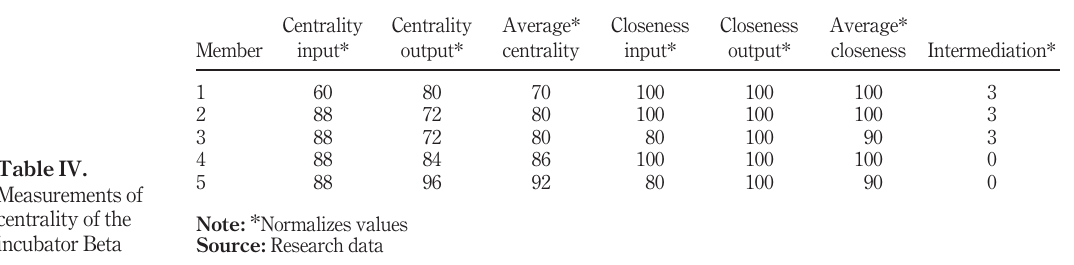
centrality of the incubator